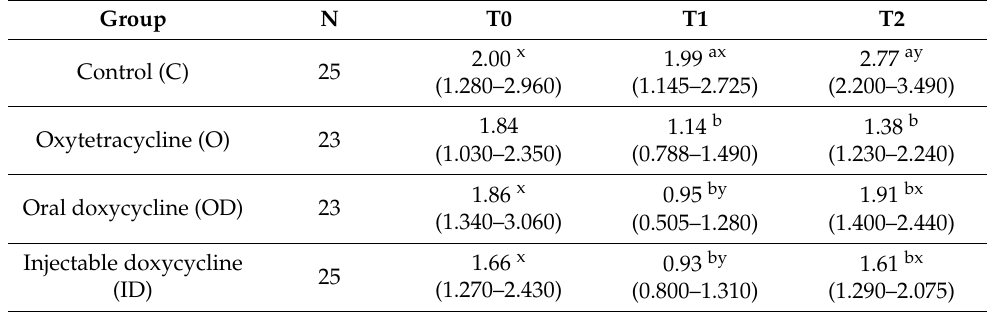
Figure 2. Median (25th and 75th percentile values) reticulocytes (K/µL) of lambs that were treated with oral doxycycline (OD). injectable doxycycline (ID). oxytetracycline (O), and untreated animals belonging to the control group (C) in the three moments that were analyzed: before treatment (T0). 12 days after treatment (T1), and 45 days after treatment (T2). Reticulocyte threshold values are between 0.0 and 15.0 K/µL. abc indicate significant differences ( p < 0.005) between treatments at the same sampling time, and xyz indicate significant differences ( p < 0.005) between the different sampling times within the same treatment. Table 4. Median (25th and 75th percentile values) monocytes (K/ µ L) of lambs that were treated with oral doxycycline (OD). injectable doxycycline (ID). oxytetracycline (O), and untreated animals belonging to the control group (C) in the three moments that were analyzed: before treatment (T0). 12 days after treatment (T1), and 45 days after treatment (T2). The monocyte threshold values are between 0.1 and 1.01 K/ µ